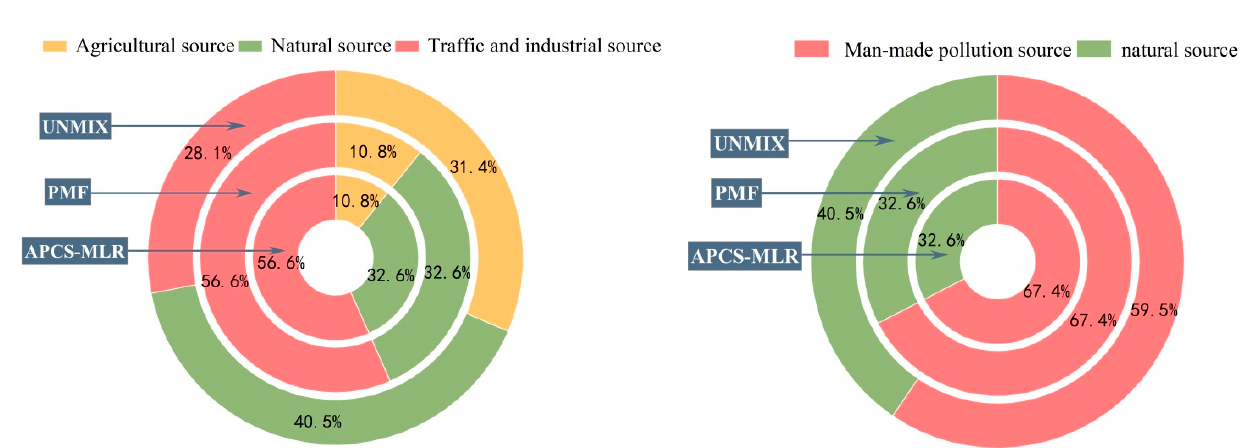
Figure 9. Estimated average source contribution (%).